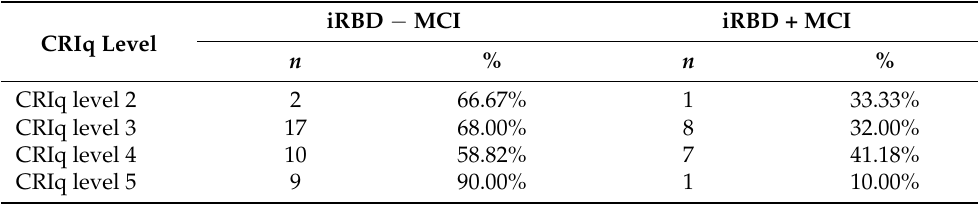
Table 3. MCI distribution.